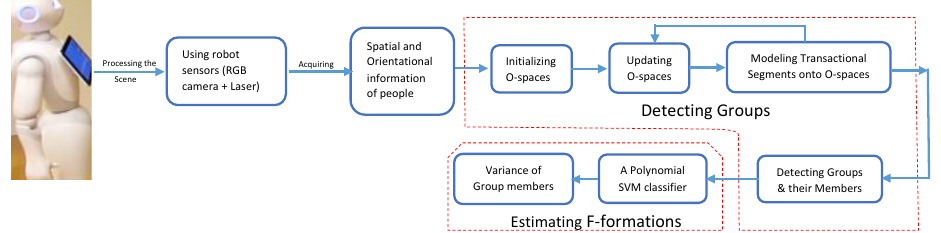
Figure 4. Overview of our framework. The robot uses on-board sensors to process the scene and extract the number of people, and the spatial and orientational information of people. These hand- engineered features are used to detect the groups—using the O-spaces and the transactional segments of people. Then, the patterns of the groups are recognized by estimating the F-formations using a classifier and the variance of group